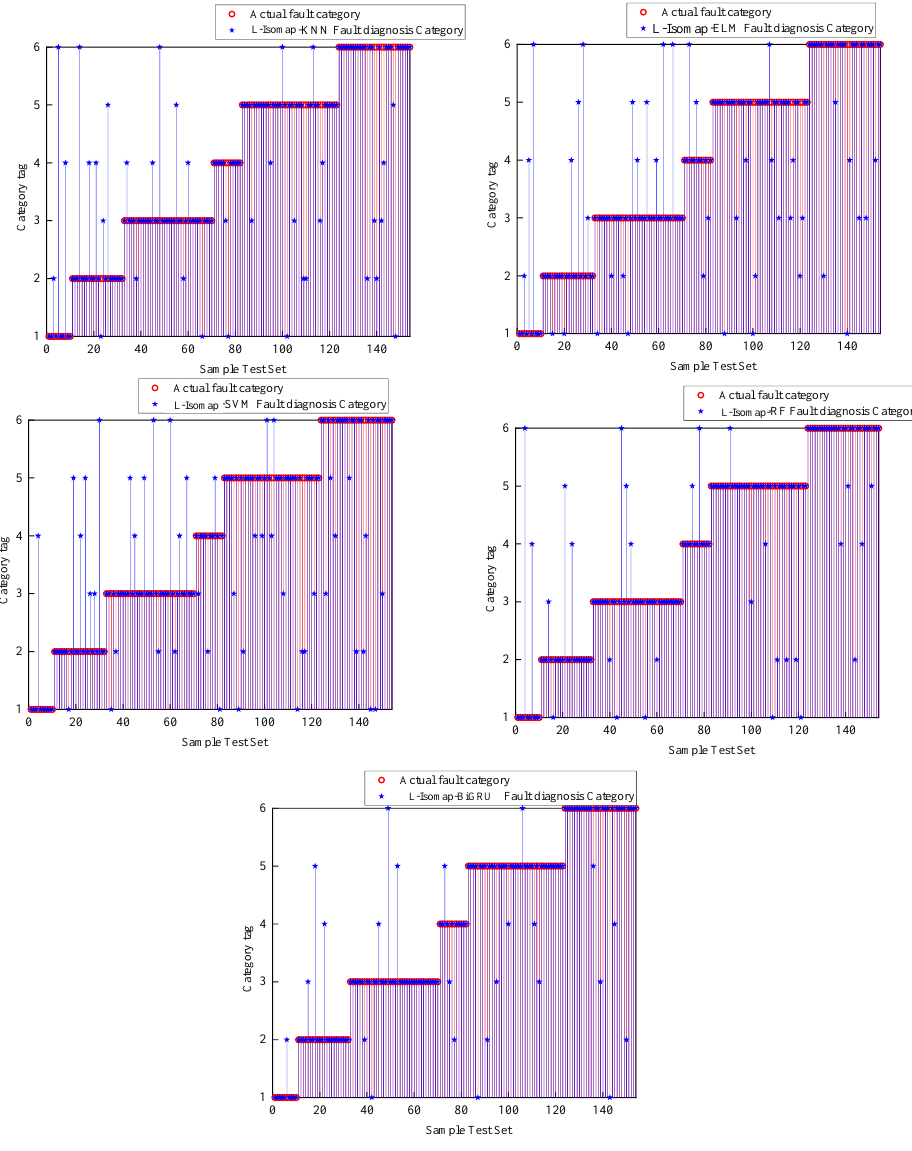
Figure 19. Adaptation change curve.